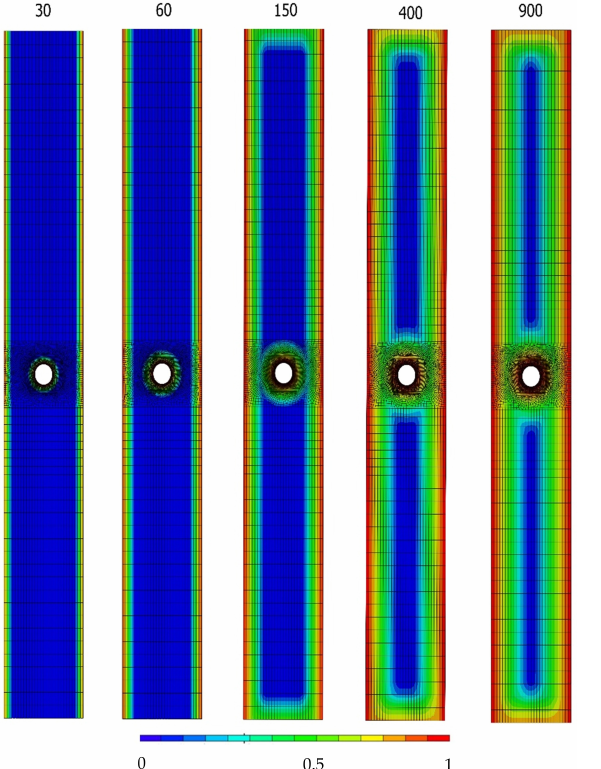
Figure 9. Prediction of the concentration of seawater after 30, 60, 150, 400 and 900 days of immersion.